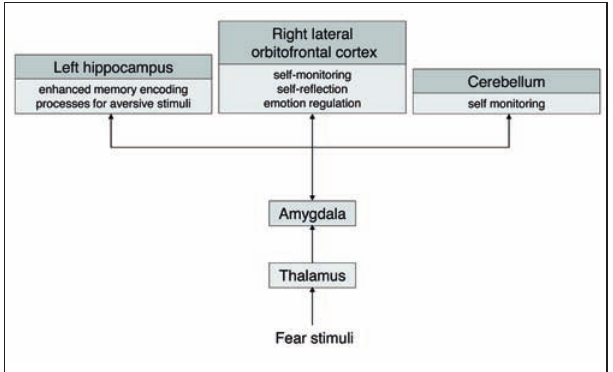
Fig. 2. Main brain areas that modulate the emotional processing of fear